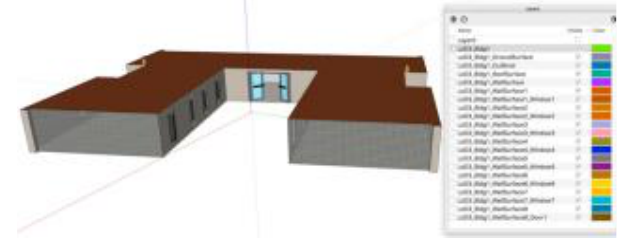
Figure 3: Assignment of Layers in Trimble SketchUp